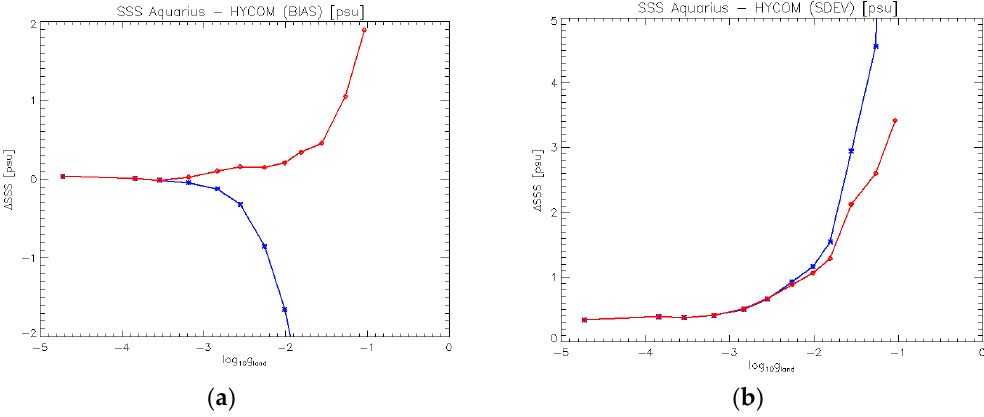
Figure 8. Comparison between Aquarius horn 2 and HYCOM salinity as function of the logarithmic gain weighted land fraction g land . Blue: Without correction for land intrusion. Red: With correction for land intrusion. ( a ) Bias. ( b ) Standard deviation.